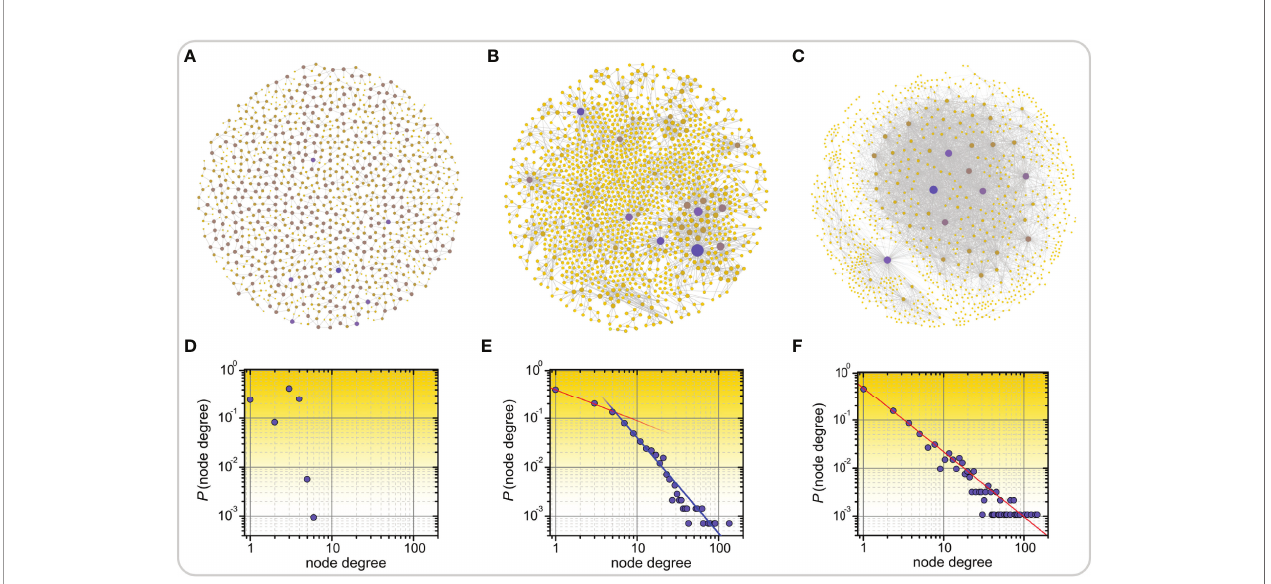
FIGURE 2 | Examples of real-world networks along with their corresponding degree distributions. Road network in California (A) , disease-disease network in which nodes represent inherited, developmental, or acquired diseases and links represent associations between them (B) , and air transport network in the US (C) . In panels (A-C) highly connected nodes, i.e., hubs, are colored purple, all other nodes are colored yellow. The lower panels feature the corresponding degree distributions of networks which are categorized as single-scale (D) , broad-scale or weakly scale-free (E) , and scale-free (F)